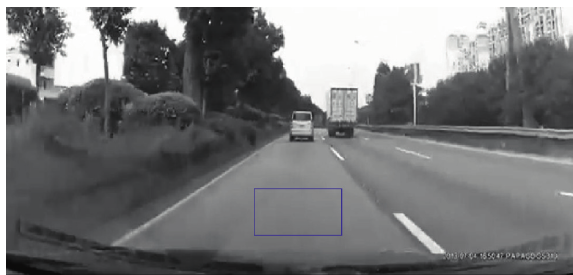
Figure 3: Statistical region of gray value samples.